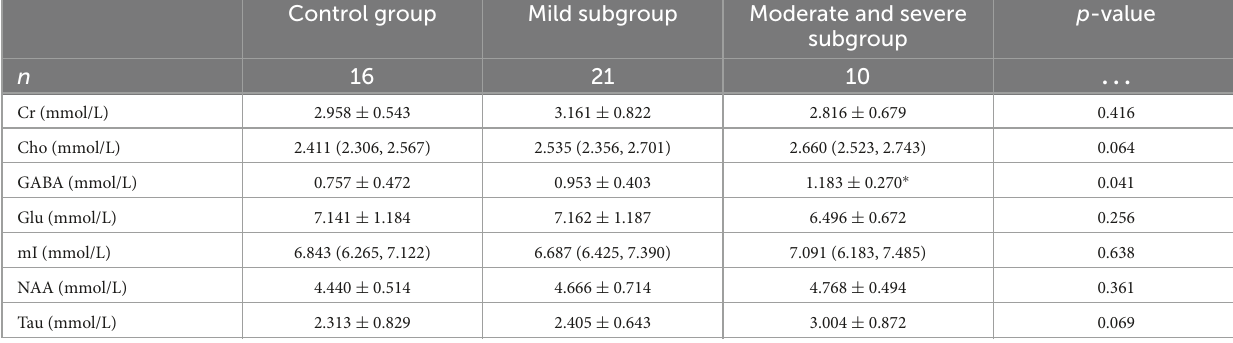
TABLE 3 Absolute concentration values of each metabolite in the right basal ganglia of acute bilirubin encephalopathy in different severity groups. Control group